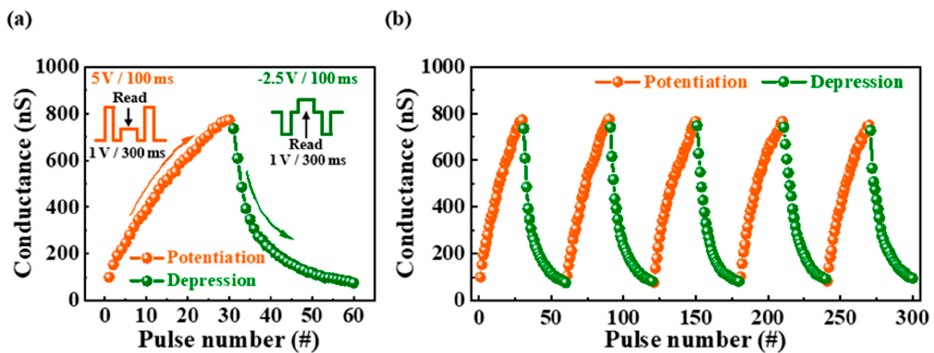
Figure 6. ( a ) Changes in channel conductance when 30 potentiation pulses and 30 depression pulses applied to pre-synapse and ( b ) endurance test of channel conductance modulation for potentia- tion/depression operation over 5